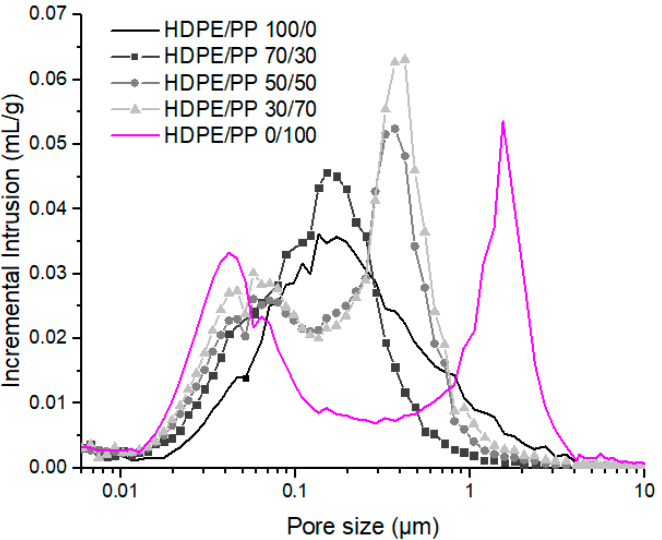
Figure 9. Pore size distribution from wax extraction in HDPE/PP/Wax blends.